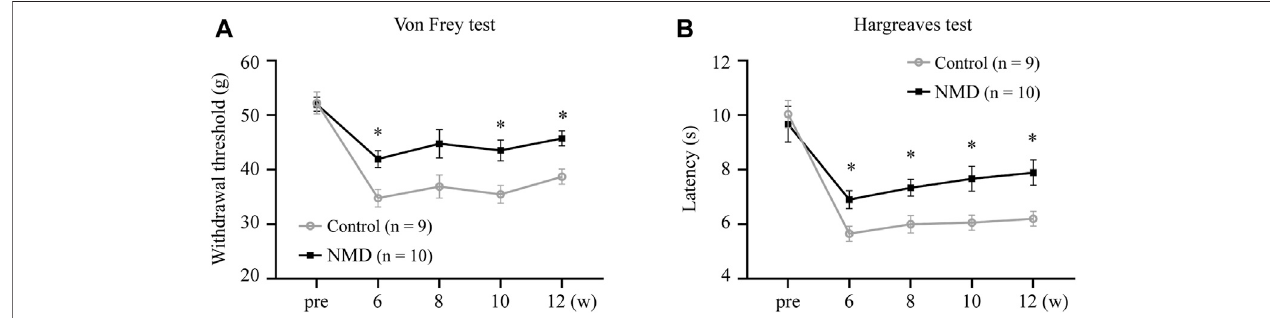
FIGURE2| Long-termtreatmentwithNMDattenuatespainrelatedbehaviors. (A) Graphshowingthewithdrawalthresholdofhindlimbsfrom6to12 weeks(NMD, n (cid:1) 10; controls, n (cid:1) 9). Two-way repeated-measures ANOVA, p < 0.05, F (1, 17) (cid:1) 8.112; post hoc Bonferroni analysis * p < 0.05 at weeks 6, 10, and 12. p (cid:1) 0.0249 (week 6), 0.0282 (week 10), and 0.0117 (week 12). (B) Graph showing the withdrawal latency of hind limbs from 6 to 12 weeks (NMD, n (cid:1) 10; controls, n (cid:1) 9). Two-way repeated-measures ANOVA, p < 0.05, F (1, 17) (cid:1) 7.109; post hoc Bonferroni analysis * p < 0.05 at weeks 6, 8, 10, and 12. p (cid:1) 0.0475 (week 6), 0.0392 (week 8), 0.0412 (week 10), and 0.0337 (week 12).